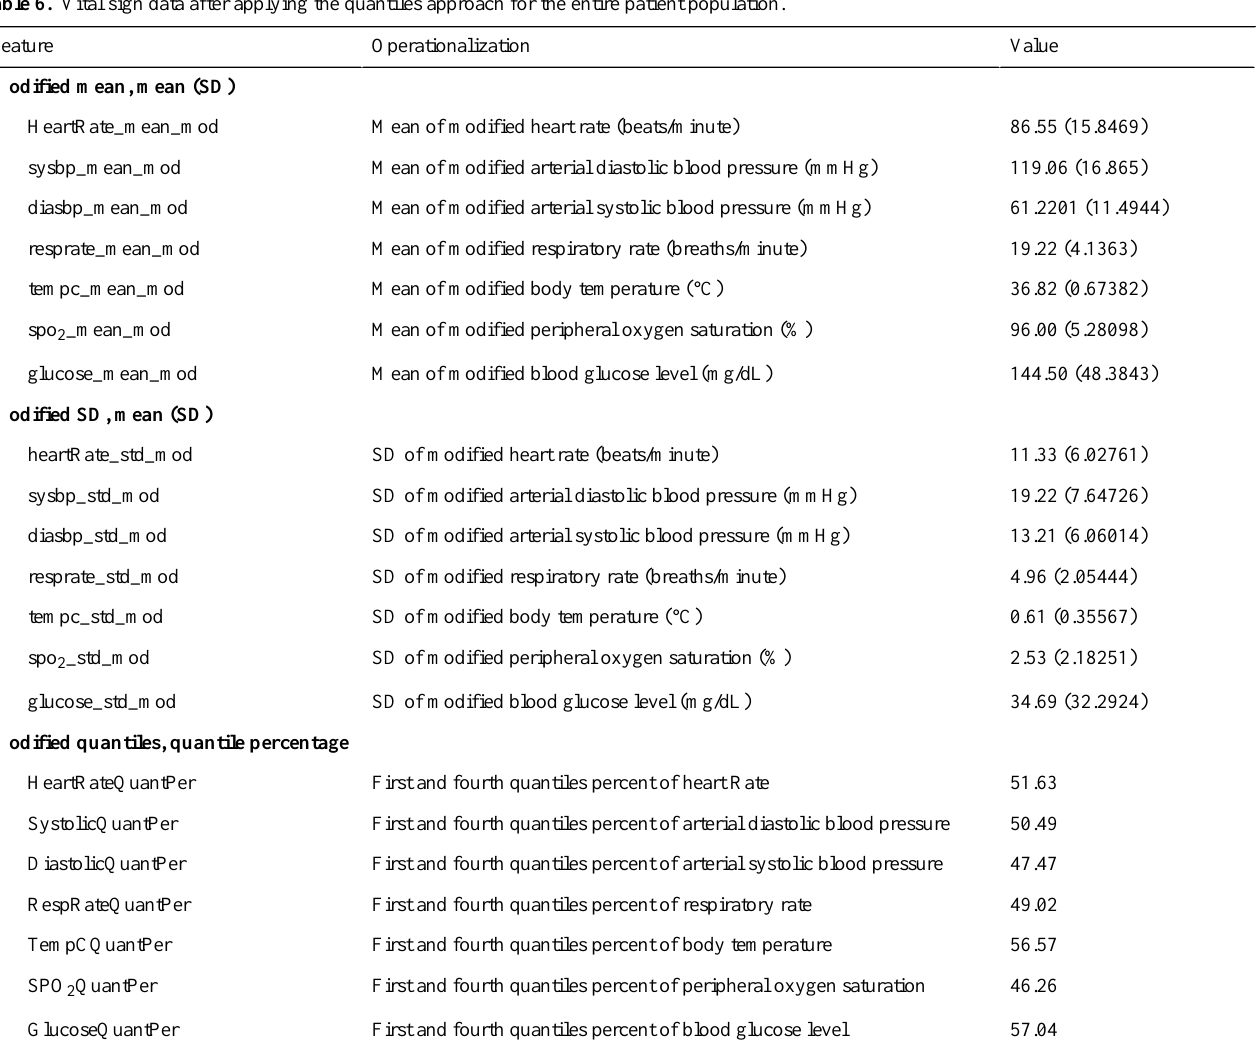
Table 6. Vital sign data after applying the quantiles approach for the entire patient population.